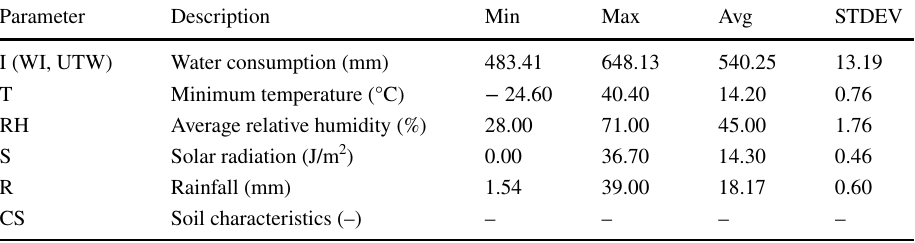
Table 4 Dataset